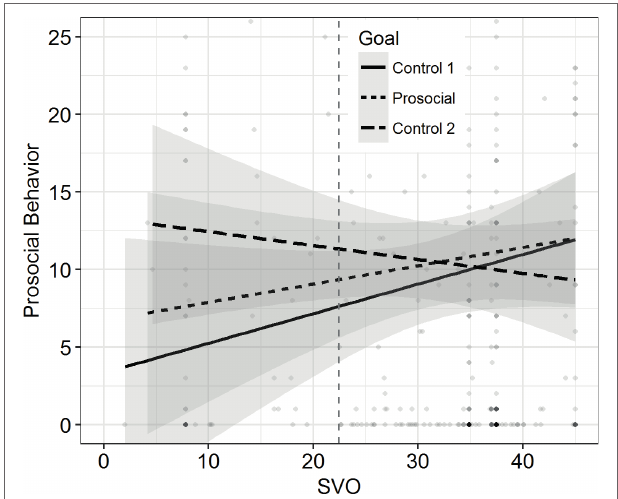
FIGURE 5 | Prosocial Behavior as a function of SVO in Study 3. Separate lines signify conditions. Shades depict 95% CIs. Higher density of the scatter signifies higher concentration of data. Vertical dashed line separates proselfs (left) from prosocials